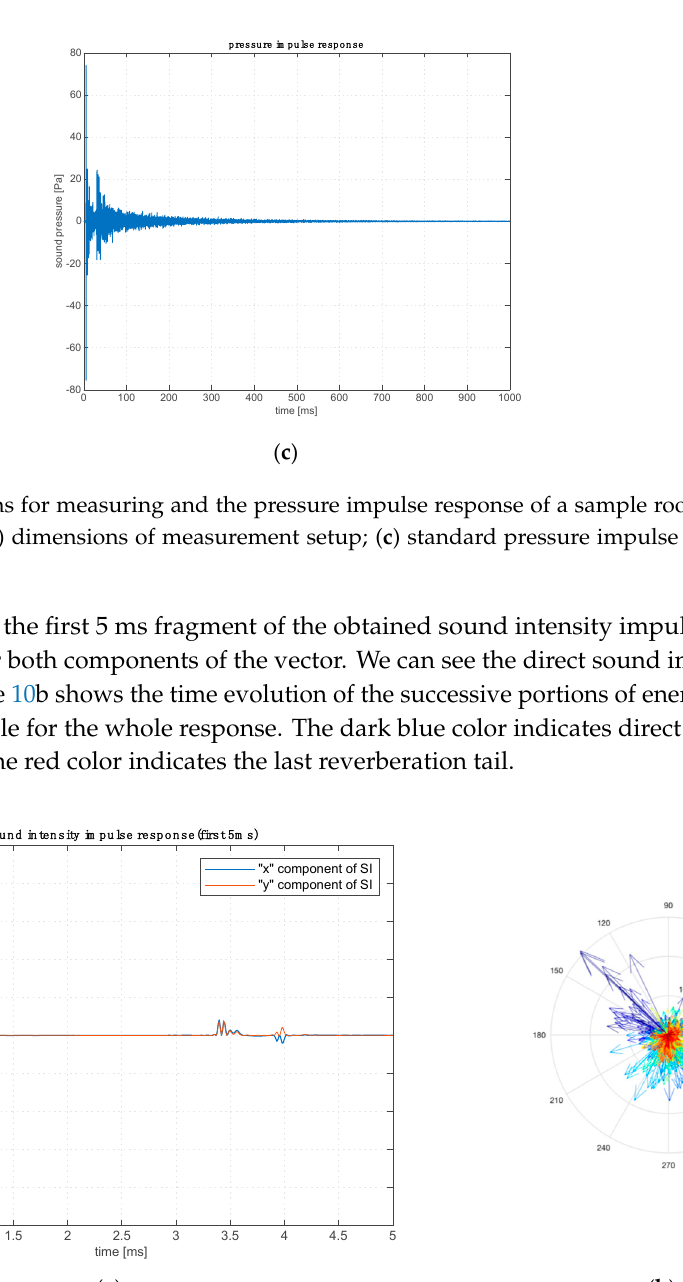
Figure 10. Sound intensity impulse response of a real room. Time evolution of two intensity vector components (first 5 ms) ( a ) and color-coded time evolution of sound intensity vector representation on a plane (whole response) ( b ).